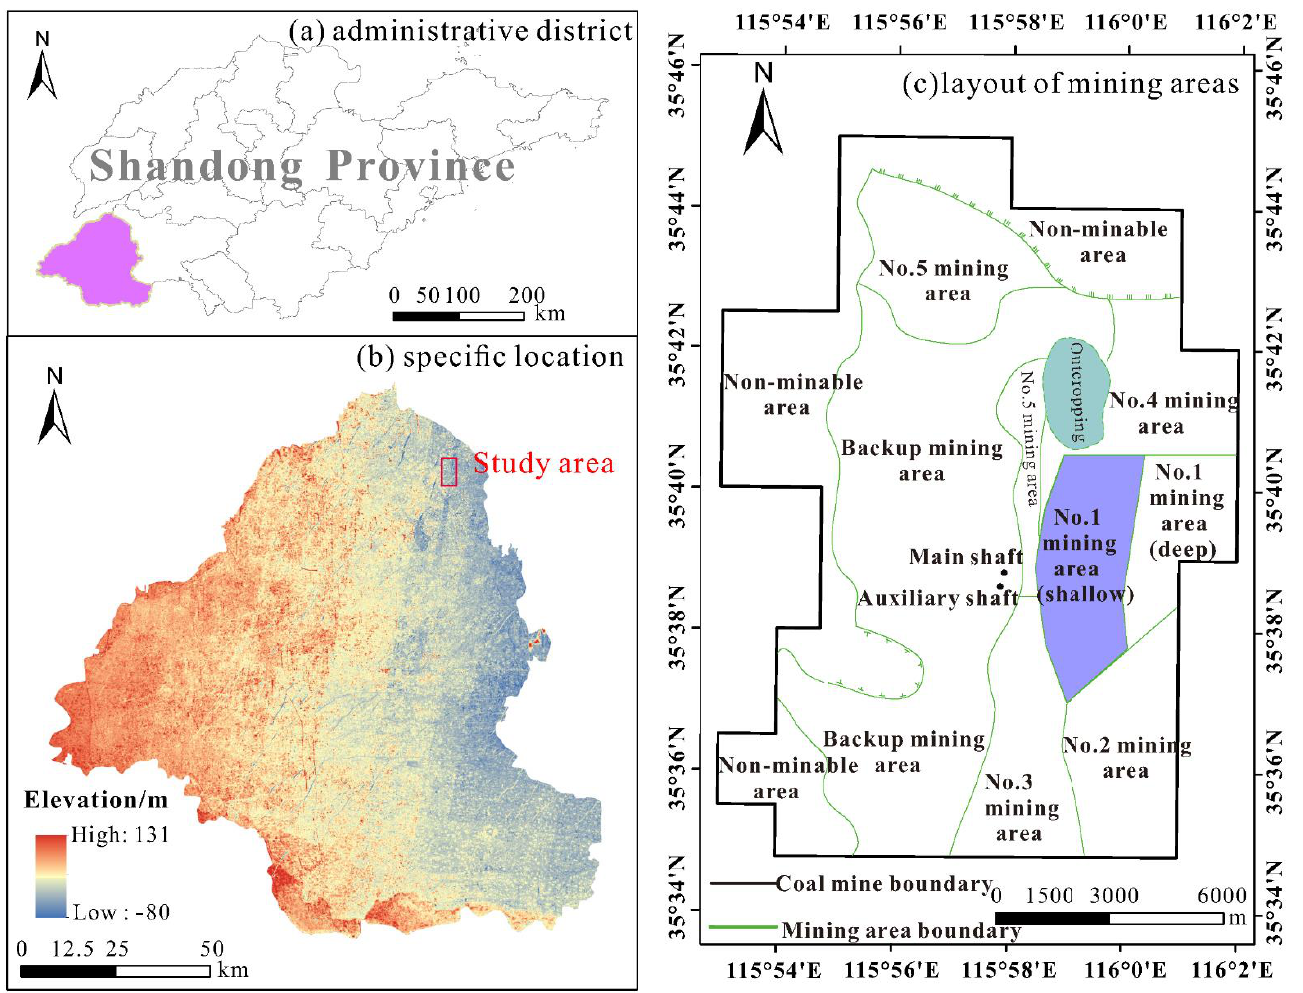
Figure 1. ( a ) describes the administrative district where the study area is located, ( b ) presents the specific location and elevation of the study area, and ( c ) depicts the layout design of mining